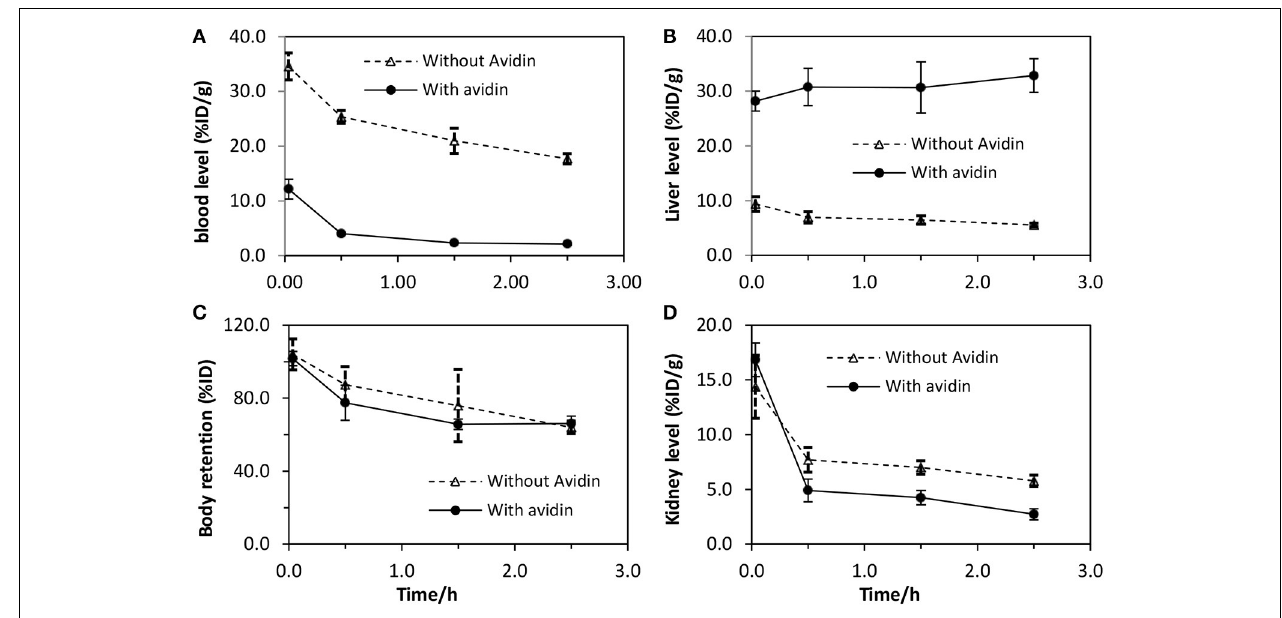
FIGURE 2 | Pharmacokinetics of both avidin-bound and radiolabeled biotin-CC49-MORF vs. radiolabeled biotin-CC49-MORF (no avidin). Shown are pharmacokinetics for (A) Blood, (B) Liver, (C)